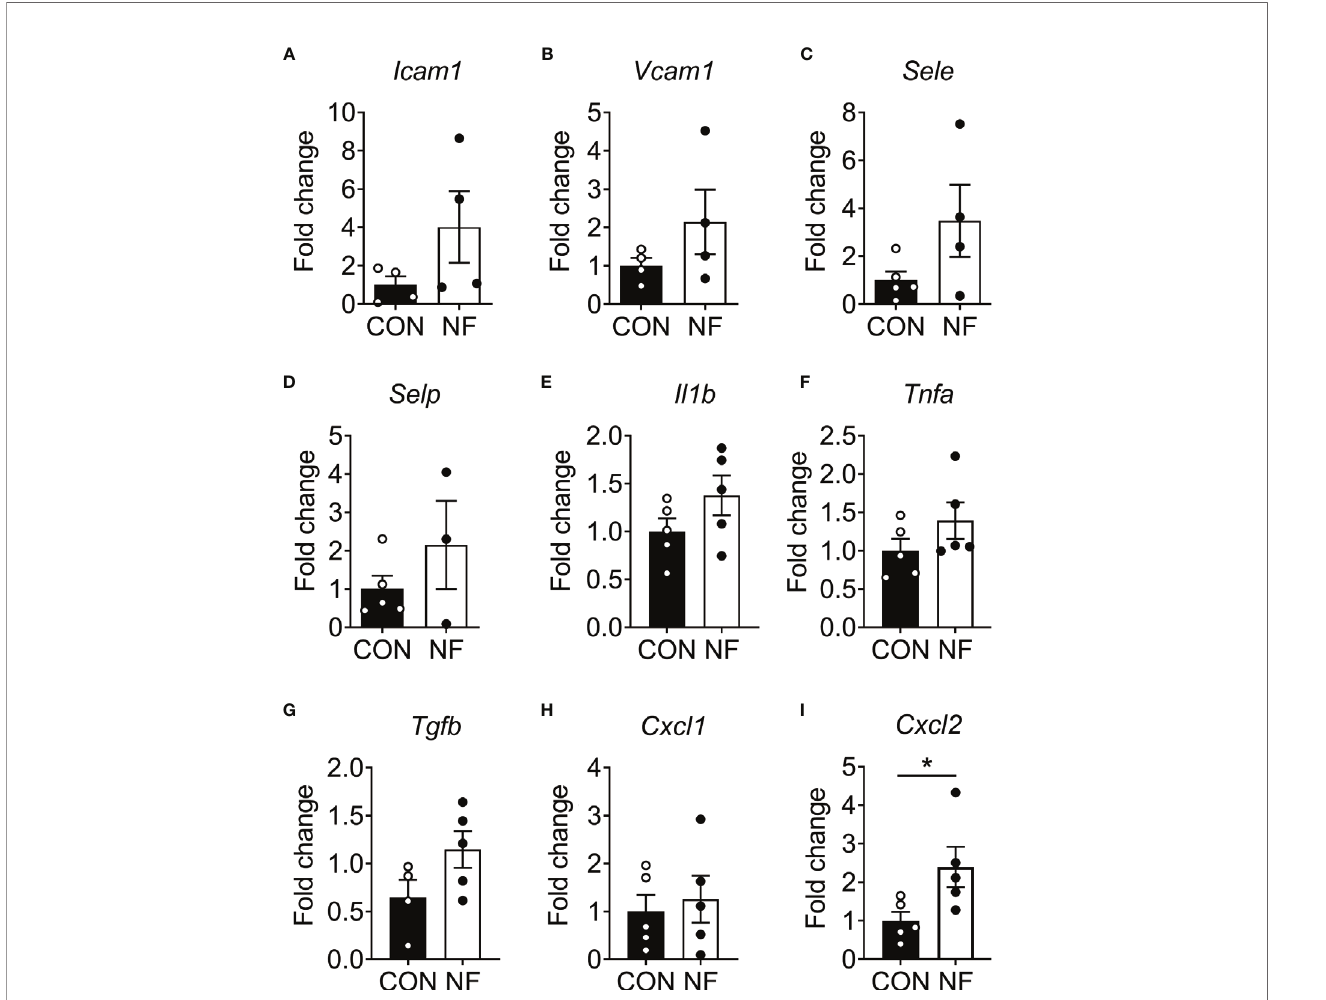
FIGURE 2 | Cytokine gene expression pro fi le in the colon following no- fi bre feeding. WT mice were fed CON or NF diet for 14 days. At day 14, the expressions of (A) Icam1 , (B) Vcam1 , (C) Sele , (D) Selp , (E) Il1b , (F) Tnfa , (G) Tgfb , (H) Cxcl1 and (I) Cxcl2 in the colon of WT mice were quanti fi ed relative to mice fed CON diet. Data displayed as mean ± SEM. Dots represent individual mice, N ≥ 4 per group, * P < 0.05 with the Mann-Whitney U